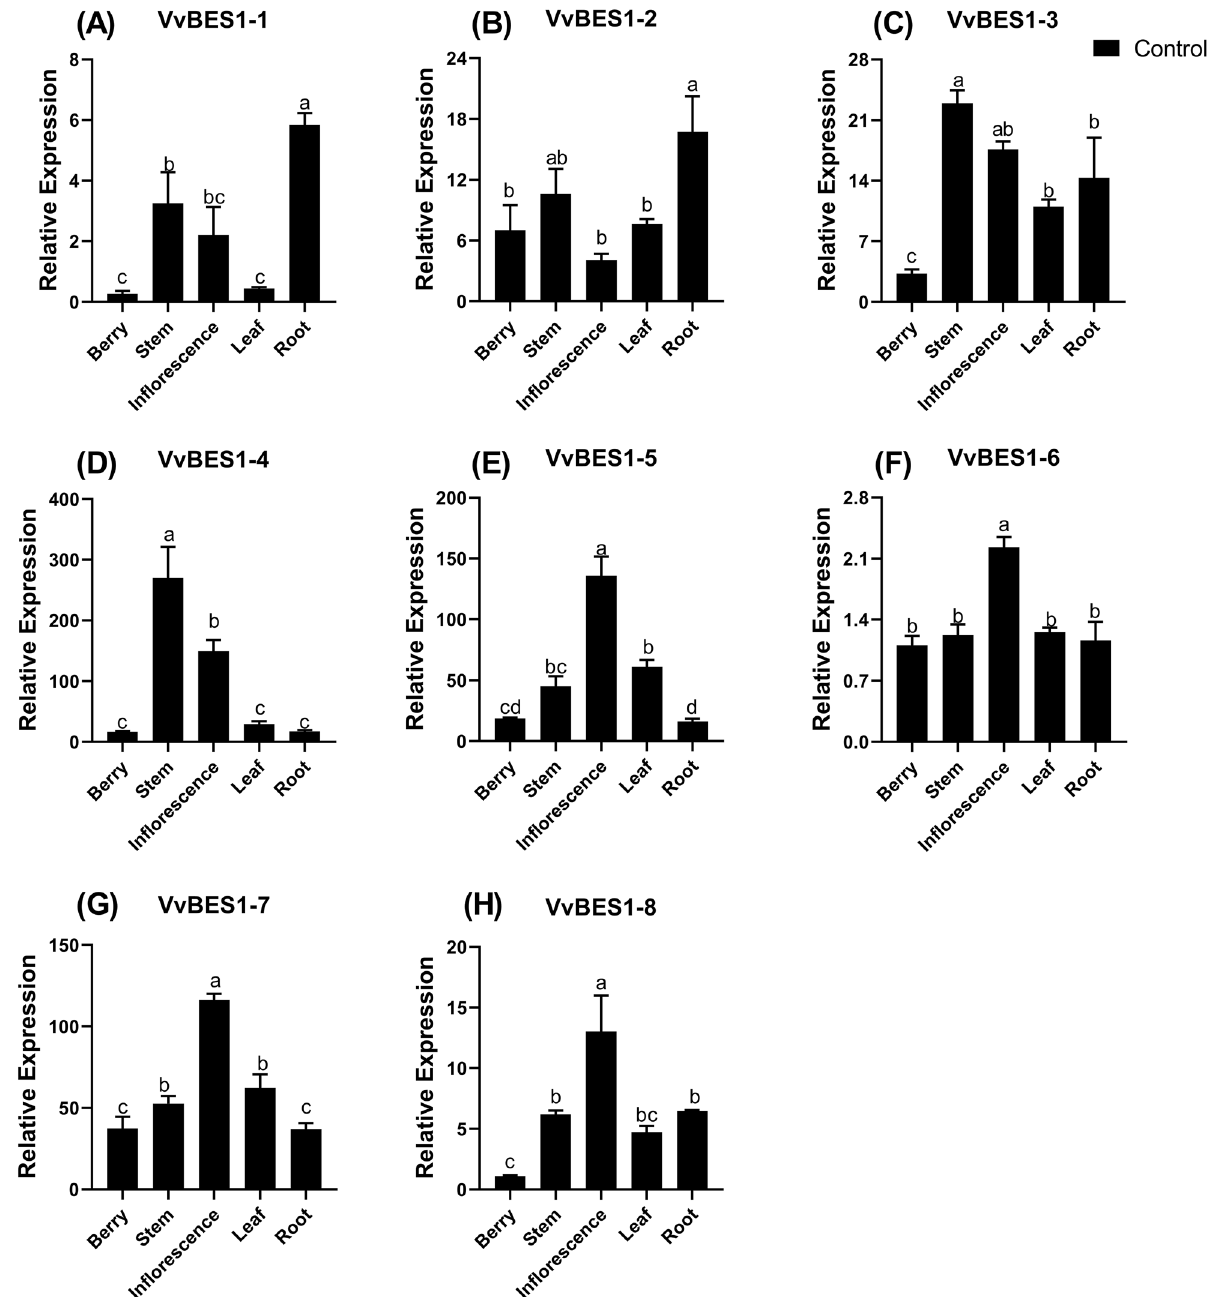
Figure 6. The expression profiles of VvBES1 genes in berry, root, leaf, stem and inflorescence. ( A ) Gene expression quantification of VvBES1-1. ( B ) Gene expression quantification of VvBES1-2. ( C ) Gene expression quantification of VvBES1-3. ( D ) Gene expression quantification of VvBES1-4. ( E ) Gene expression quantification of VvBES1-5. ( F ) Gene expression quantification of VvBES1-6. ( G ) Gene expression quantification of VvBES1-7. ( H ) Gene expression quantification of VvBES1-8. The error bars represent ± SE (n = 3), and the relative expression changes are relative to the control group (VvBES1-1 of berry), which are represented as log 2 fold change. The one-way Duncan’s new multiple-range test was implemented to assess the significance of differences among treatments (p <